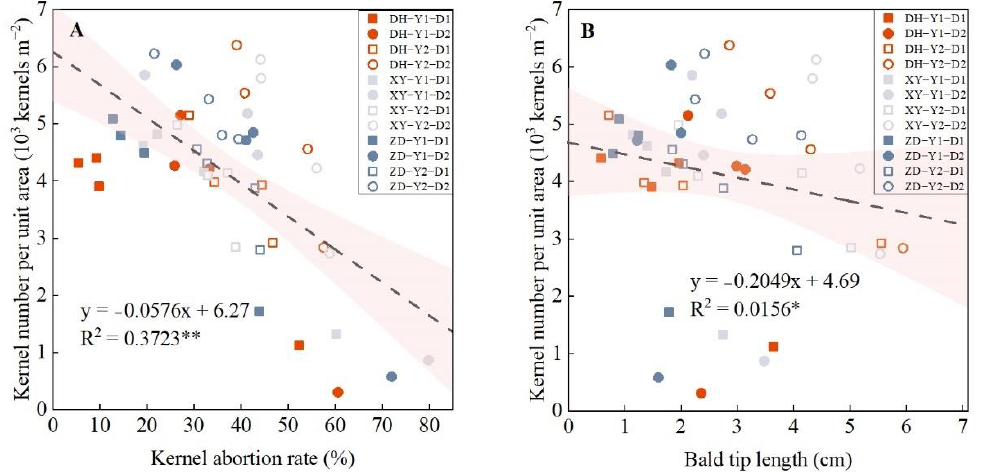
Figure 3. Relationships between the kernel number per unit area and the kernel abortion rate ( A ) and bald tip lengths ( B ). Cultivars: DH, DH618; XY, XY335; ZD, ZD958. Planting densities: D1, 7.5 × 10 4 plants ha − 1 and D2: 12 × 10 4 plants ha − 1 . The experimental years, 2019 (Y1) and 2020 (Y2), are indicated by solid and empty symbols, respectively. * p ≤ 0.05, ** p ≤ 0.01.